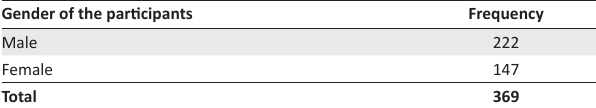
TABLE 1: Demographic information – Gender. Gender of the